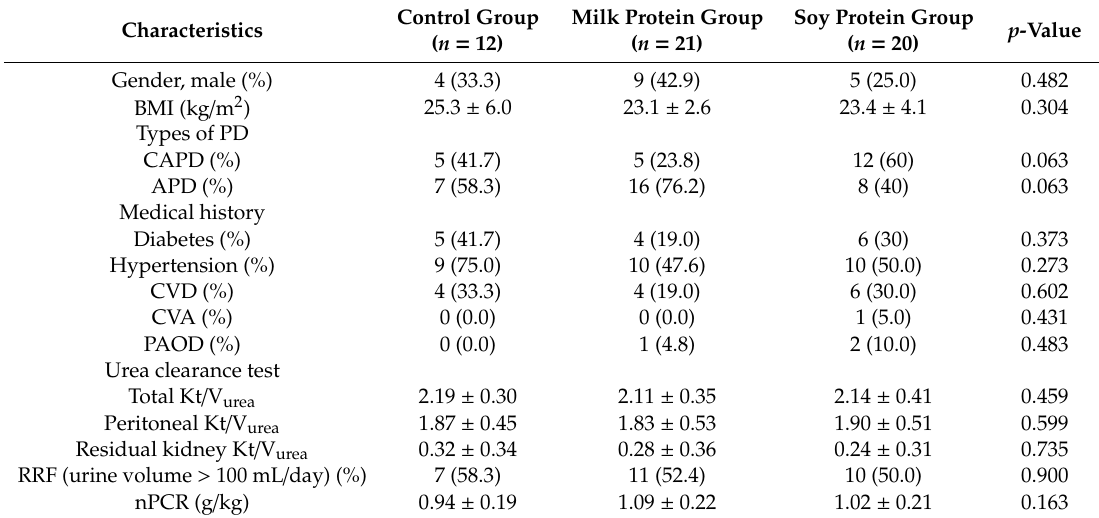
Table 2. Characteristics of peritoneal dialysis patients at